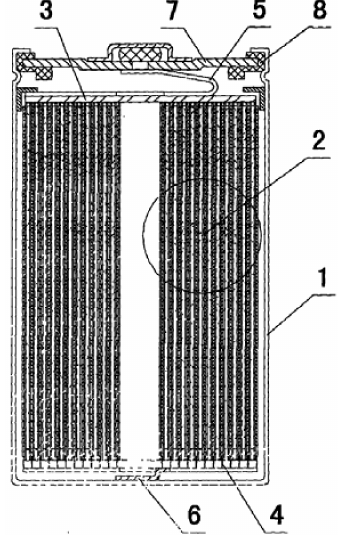
Figure 14. Schematic diagram of a high-power cell with 1: can, 2: electrode assembly, 3: positive electrode, 4: negative electrode, 5: positive current collector, 6: negative current collector, 7: vent cap, and 8: sealing ring